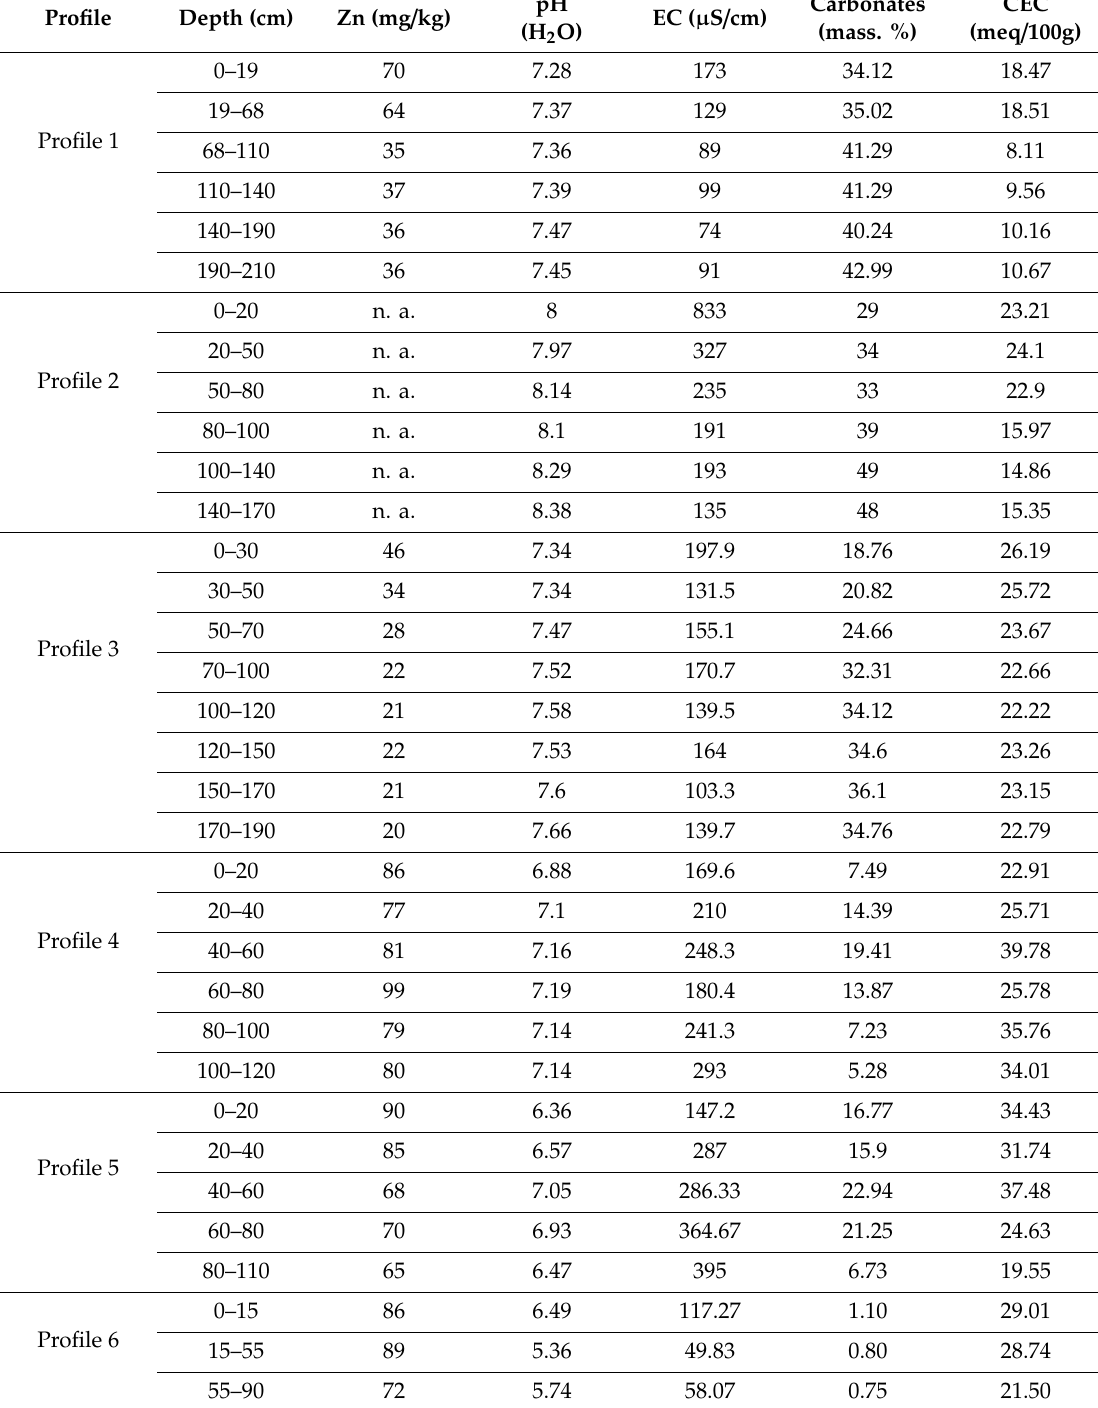
Table 3. Chemical properties of the investigated soils. Not analyzed (n.a.); electrical conductivity (EC); cation exchange capacity